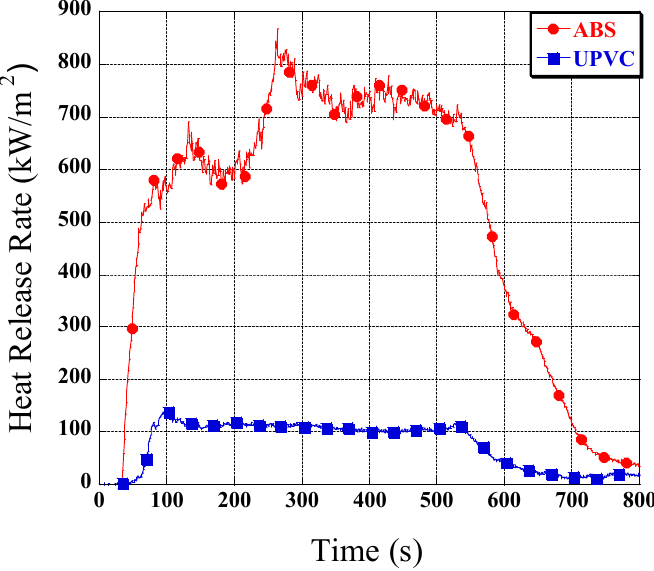
Figure 3. Heat release rate (HRR) measured as a function of time.